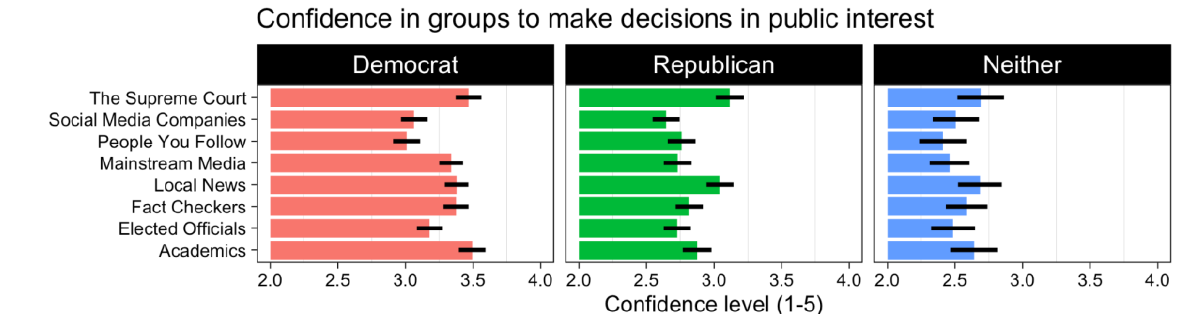
Figure 6. Trust in specific institutions by party. This grid shows mean confidence – 1.96 standard errors measured on a 6-point scale (x- axis) in specific American “institutions” (y -axis), originally asked in a series of Pew Research Center surveys (with the addition of People You Follow), for each respondent group (columns), used to create the institutional trust measure used in the paper.